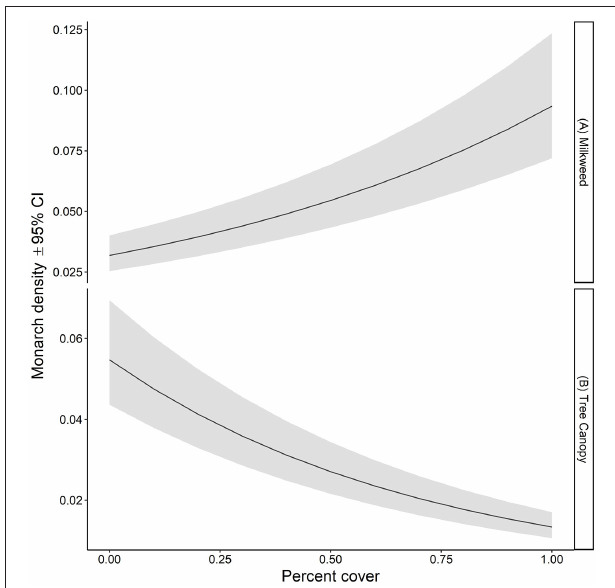
FIGURE 4 | Estimated density per 50-m2 (95% CI) of monarchs as a function of (A) percent of plots containing milkweed and (B) percent tree canopy cover on all survey transects in Iowa,